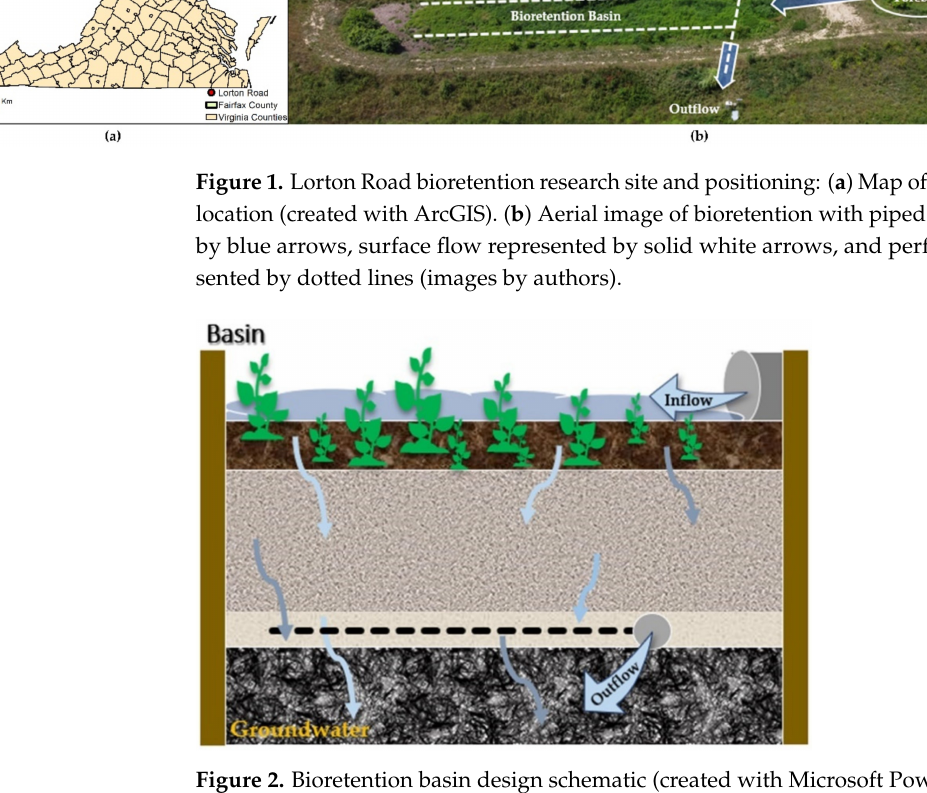
Figure 2. Bioretention basin design schematic (created with Microsoft